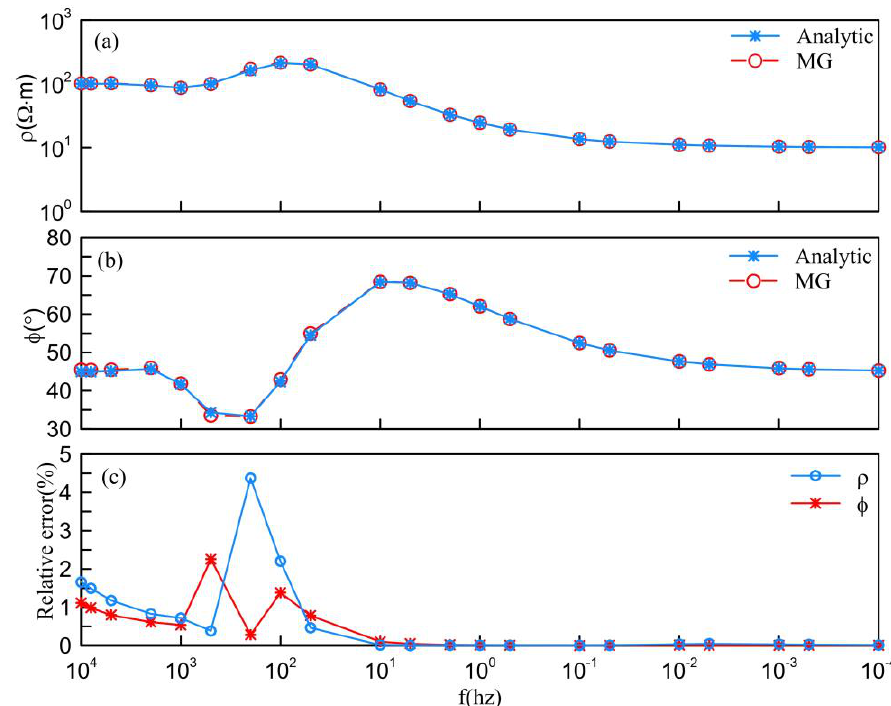
Figure 4. A three-layered synthetic model.